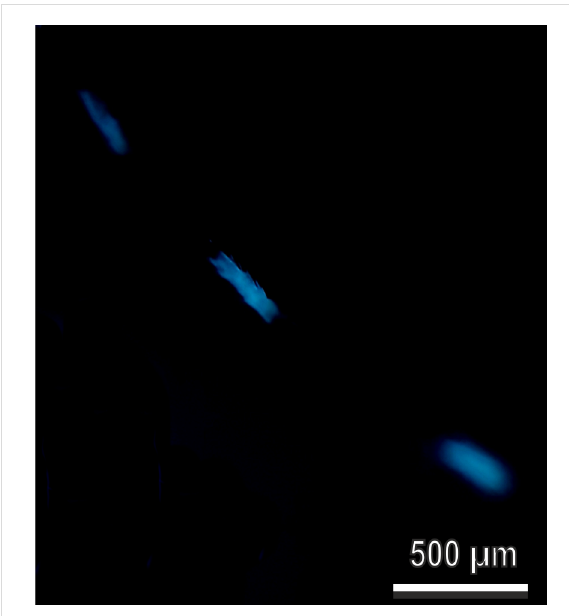
Figure 8: Tarsal black and white scales of Aedes albopictus (female) in a fluorescence microscope. Tarsi observed with an excitation filter 365 nm, chromatic beam splitter FT 395 nm, emission 397 nm. Note the blue autofluorescence of the white areas of the